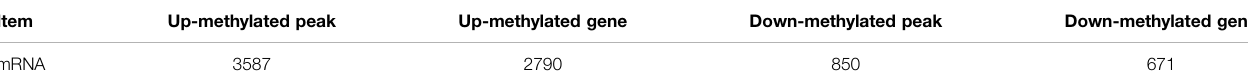
TABLE 1 | Total numbers of differentially methylated peaks and relative genes.